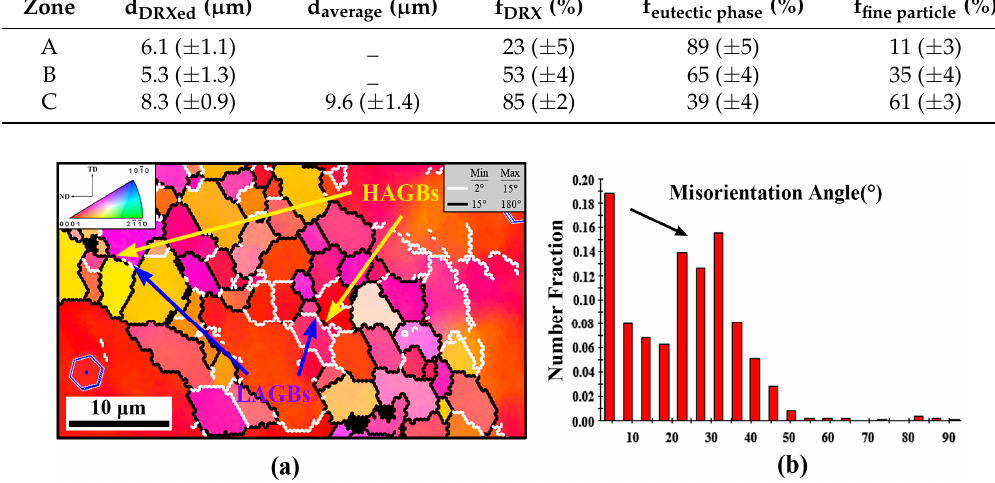
Figure 4. Microstructure of zone A: ( a ) optical microscopy OM, ( b ) SEM, and ( c ) electron backscattering diffraction apparatus (EBSD), where the color key triangle shows the crystallographic orientation of the hexagonal close-packed (HCP) crystal. Table 2. The dynamic recrystallized (DRXed) grain size, average grain size, dynamic recrystallization (DRX) fraction, and relative fraction of eutectic phase to fine particle of zones A, B, and C, respectively. Zone d DRXed ( µ m) d average ( µ m) f DRX (%)